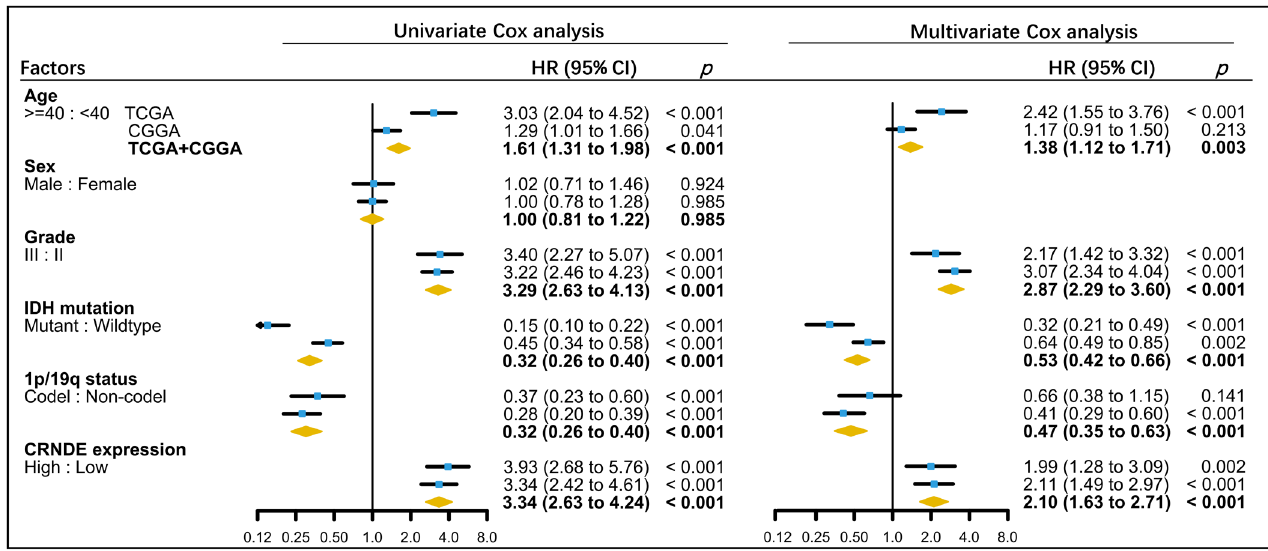
Figure 4. Association of clinical and molecular factors with OS based on univariate and multivariate Cox regression analyses of LGG patients in TCGA, CGGA, and the whole dataset.